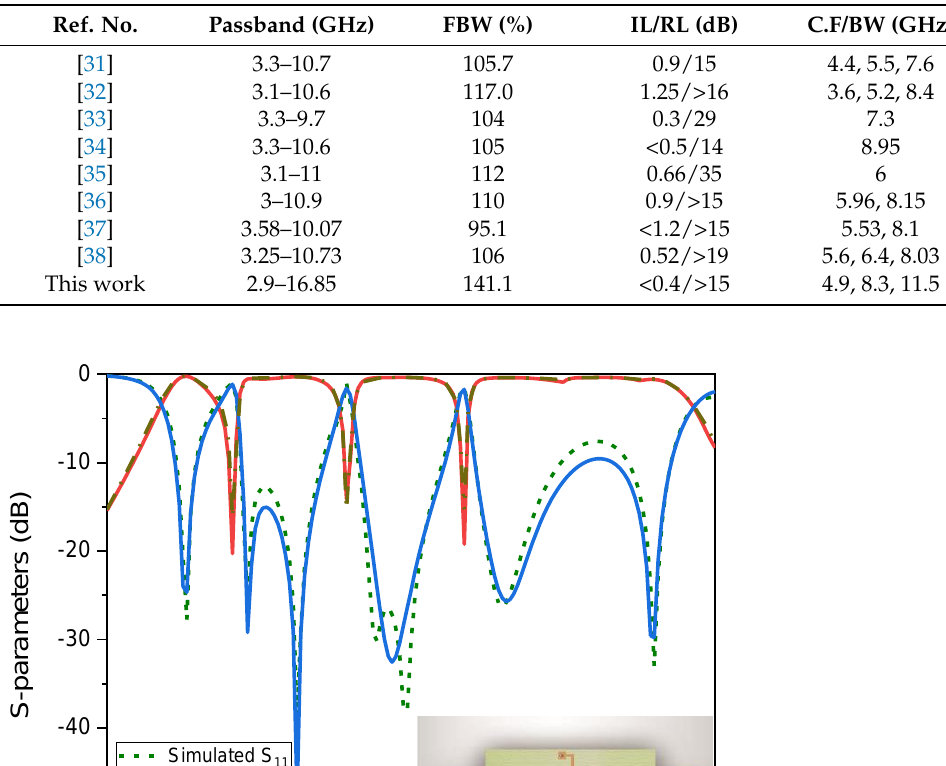
Table 6. Performance comparison of various notched filters.